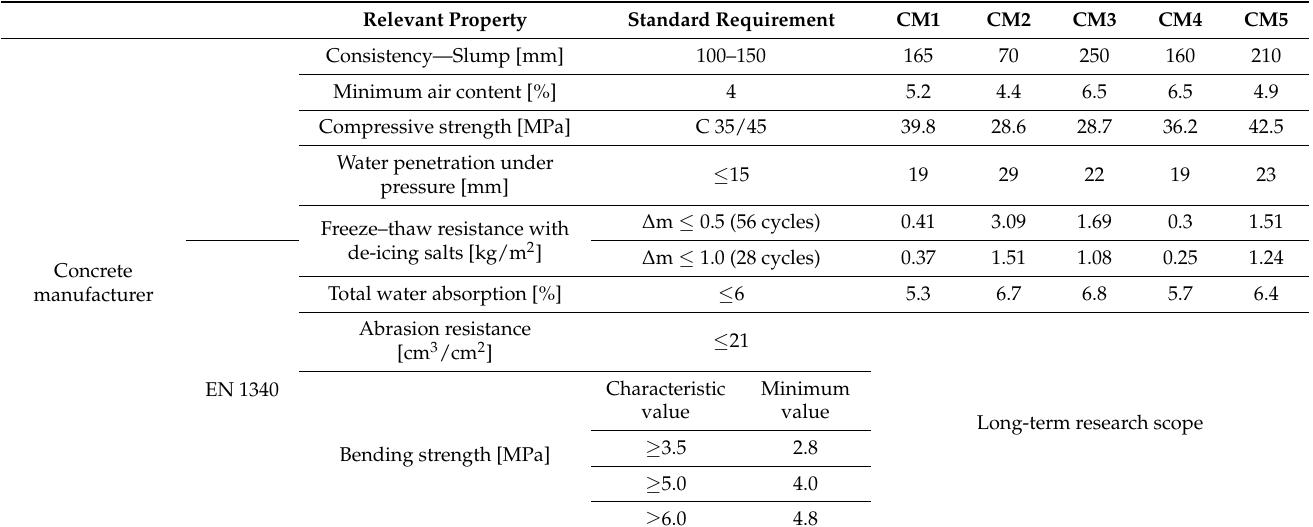
Table 11. Assessment recap of concrete mixes with WBA in relation to performance